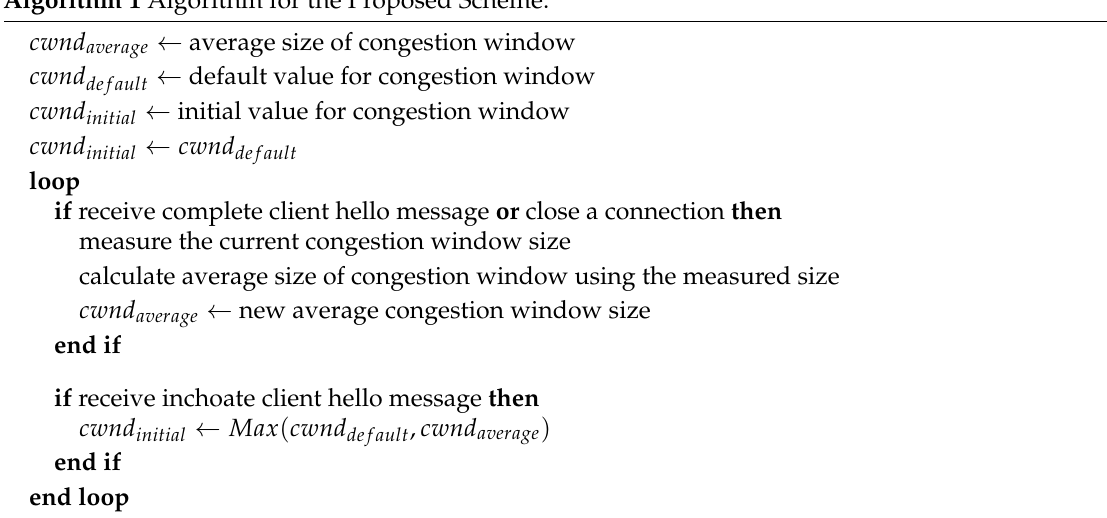
Algorithm 1 Algorithm for the Proposed Scheme.